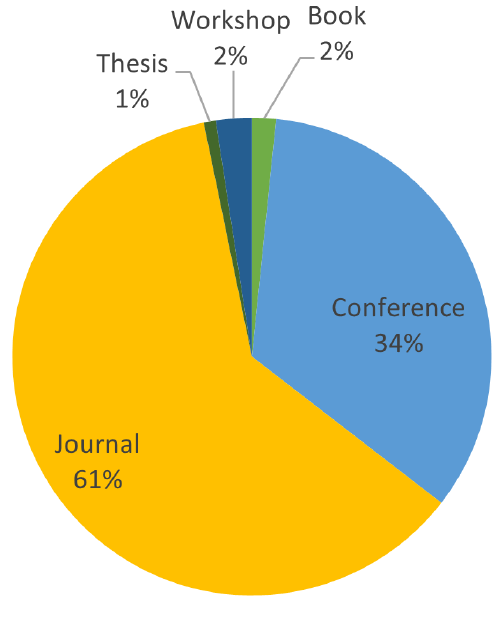
Figure 6. Distribution by type.